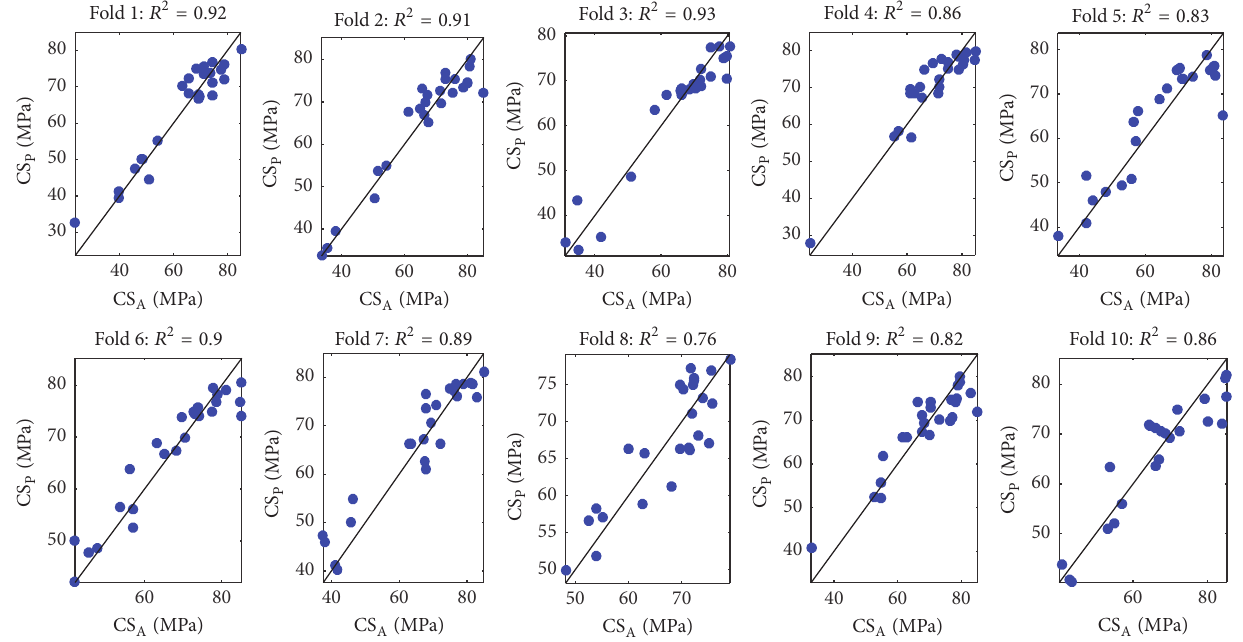
Figure 4: LSSVM prediction result obtained from the 10-fold cross validation.